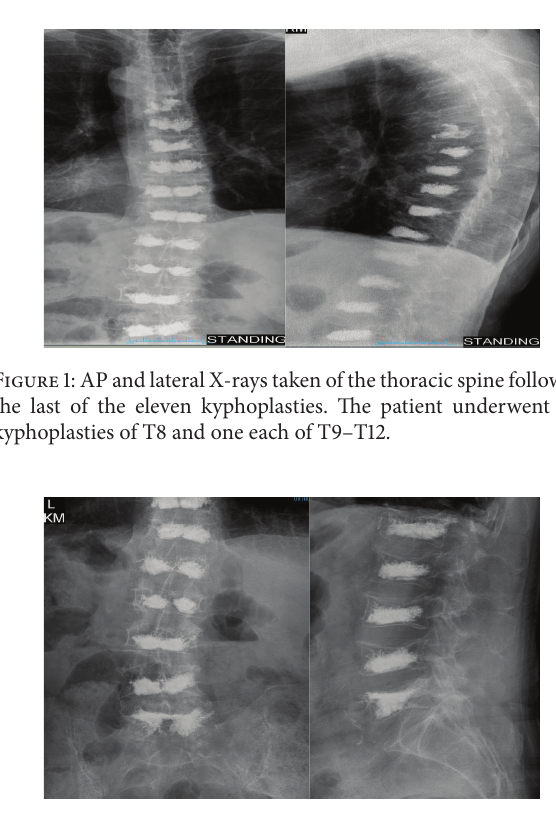
Figure 2: AP and lateral X-rays of the lumbar spine following the last kyphoplasty. The patient underwent one kyphoplasty of each lumbar vertebral